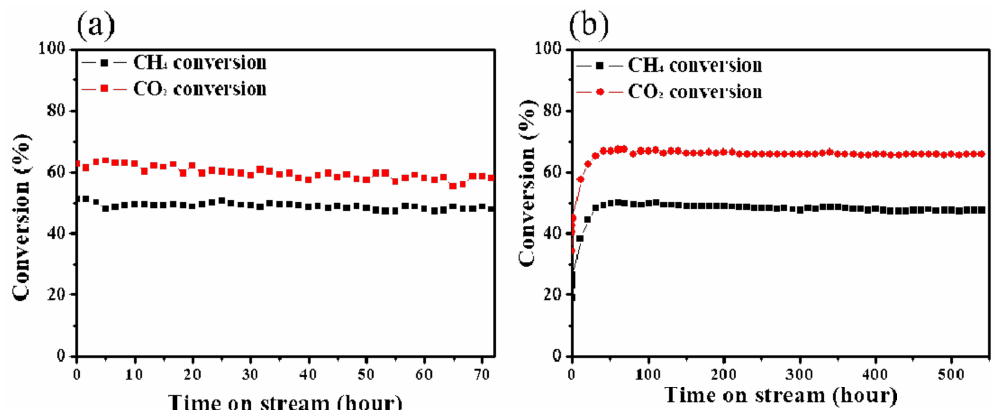
Figure 10. ( a ) CH 4 and CO 2 conversion of Ni/TiO 2 catalysts at 800 ◦ C for 72 h. ( b ) CH 4 and CO 2 conversion of Ni/alumina at 800 ◦ C for 550 h. The DRM reactions were carried out at 800 ◦ C under atmospheric conditions with a constant flow of the gas mixture (CH 4 :CO 2 = 1:1, total flow rate of 20 mL/min). Edited from Reference